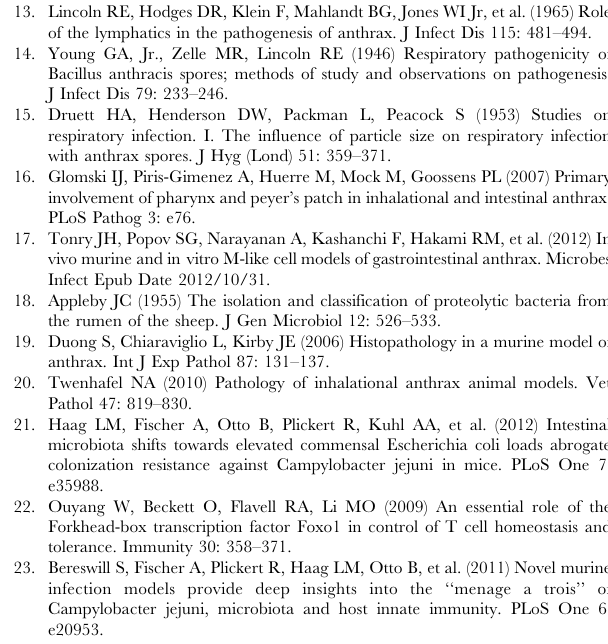
TCR- b staining (left panels); TCR- b + -gated cells were subse- quently assessed for CD4 and CD8 expression (right panels). ( B ) CD4 + and CD8 + subsets, in turn, were assessed for CD44, CD62L and CD69 expression. Activated T cells are CD44 + CD62L 2 and/ or CD69 + . ( C ) B cells were identified through B220 staining (left panels). ( D ) B220 + -gated cells were subsequently assessed for MHCII and CD40, markers of B cell activation. ( E ) Dendritic cells were identified through CD11c staining. ( F ) CD11c + -gated cells were subsequently assessed for MHCII, CD80, and CD86 expression, markers of dendritic cell activation. Figure S3 Intestinal anthrax infection has minimal effects on inflammatory cytokine production. Samples from the jejunum and ileum were obtained 48 h following gavage with BaS (infected, I) or PBS (control, C) and were cultured ex vivo . Cytokine/chemokine levels in the supernatants of these ex vivo small intestine cultures (normalized to tissue weight) were assessed and are shown, with each dot representing the results for one animal (n= 4 for each treatment group).